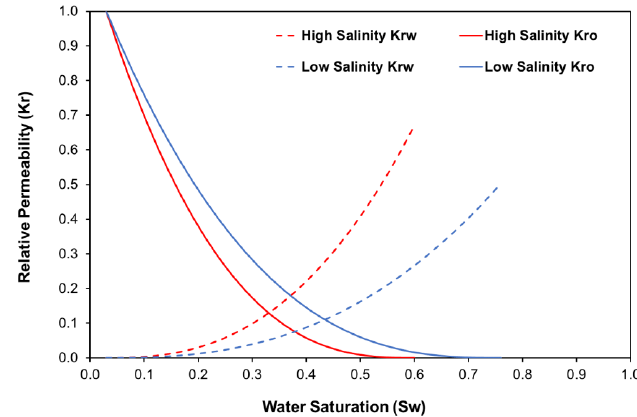
Figure 18. Relative permeability for high and low salinity water. Table 11. Composition of formation and injection water.